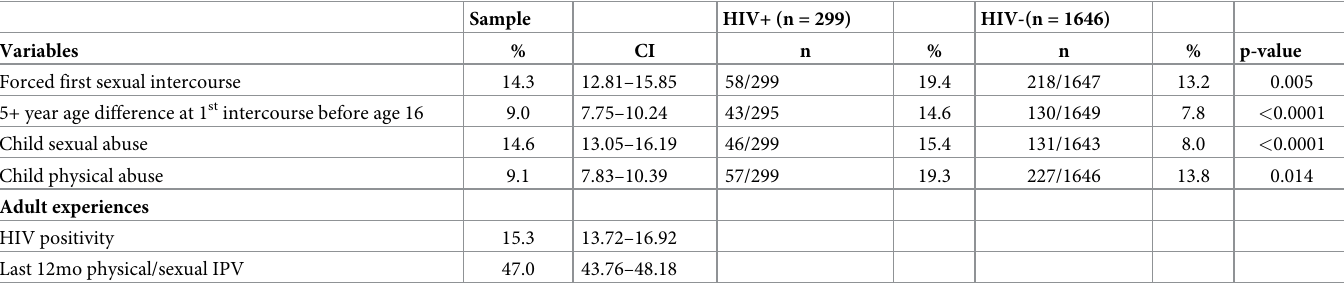
Table 2. Prevalence of childhood abuse by HIV status (N =